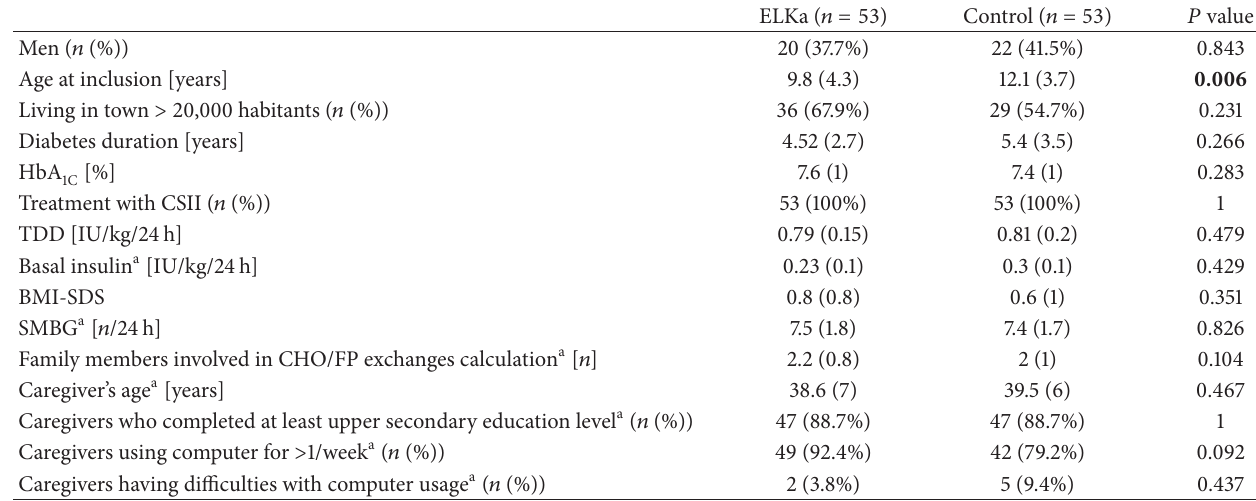
Table 1: Baseline characteristics of the study